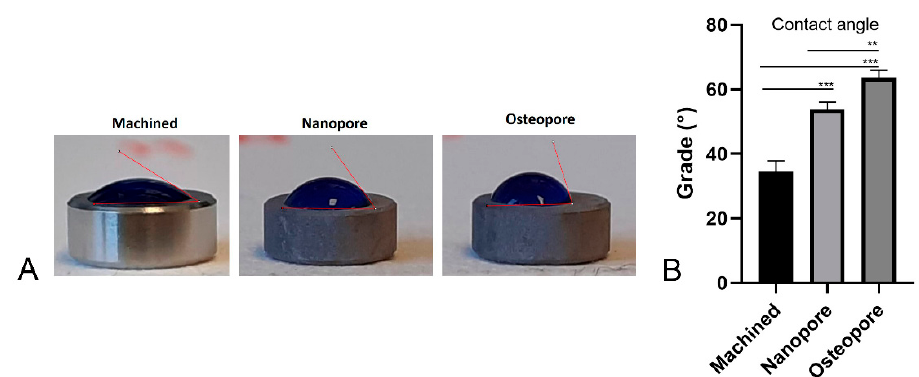
Figure 2. Water contact angle measurement. ( A ) Pictures of the WCA on the different surfaces, during the sessile drop method. ( B ) Water contact angle values (** p < 0.001 ; *** p ≤ 0.0001; Machined vs. Nanopore p = 0.0001; Machined vs. Osteopore p < 0.0001 ; Nanopore vs. Osteopore p < 0.001) .